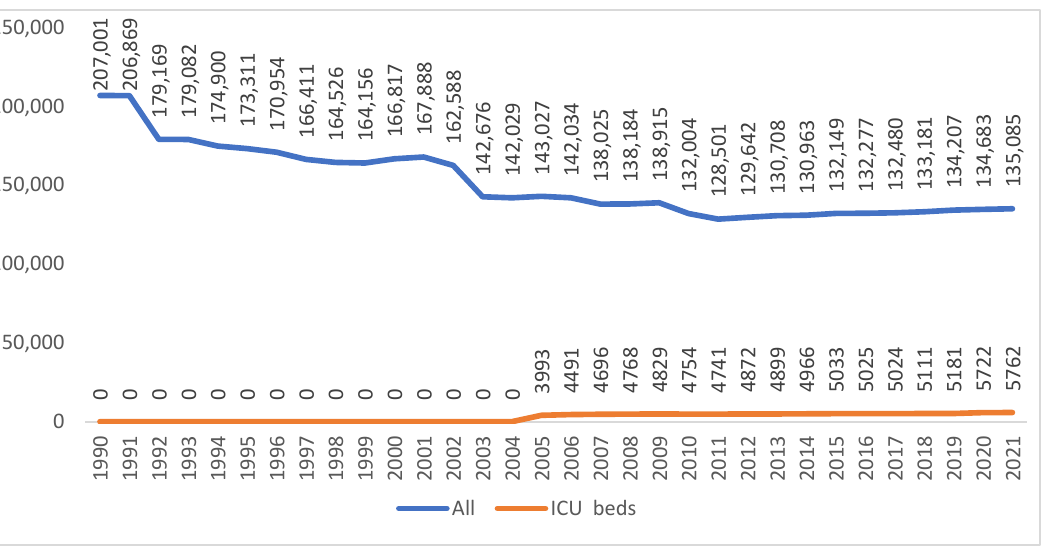
Figure 1. The evolution of the number of beds within hospitals and those from intensive care units in Romania within the period of 1990 – 2021. (http://statistici.insse.ro:8077/tempo-online/#/pages/tables/insse-table accessed on 20 July 2022).